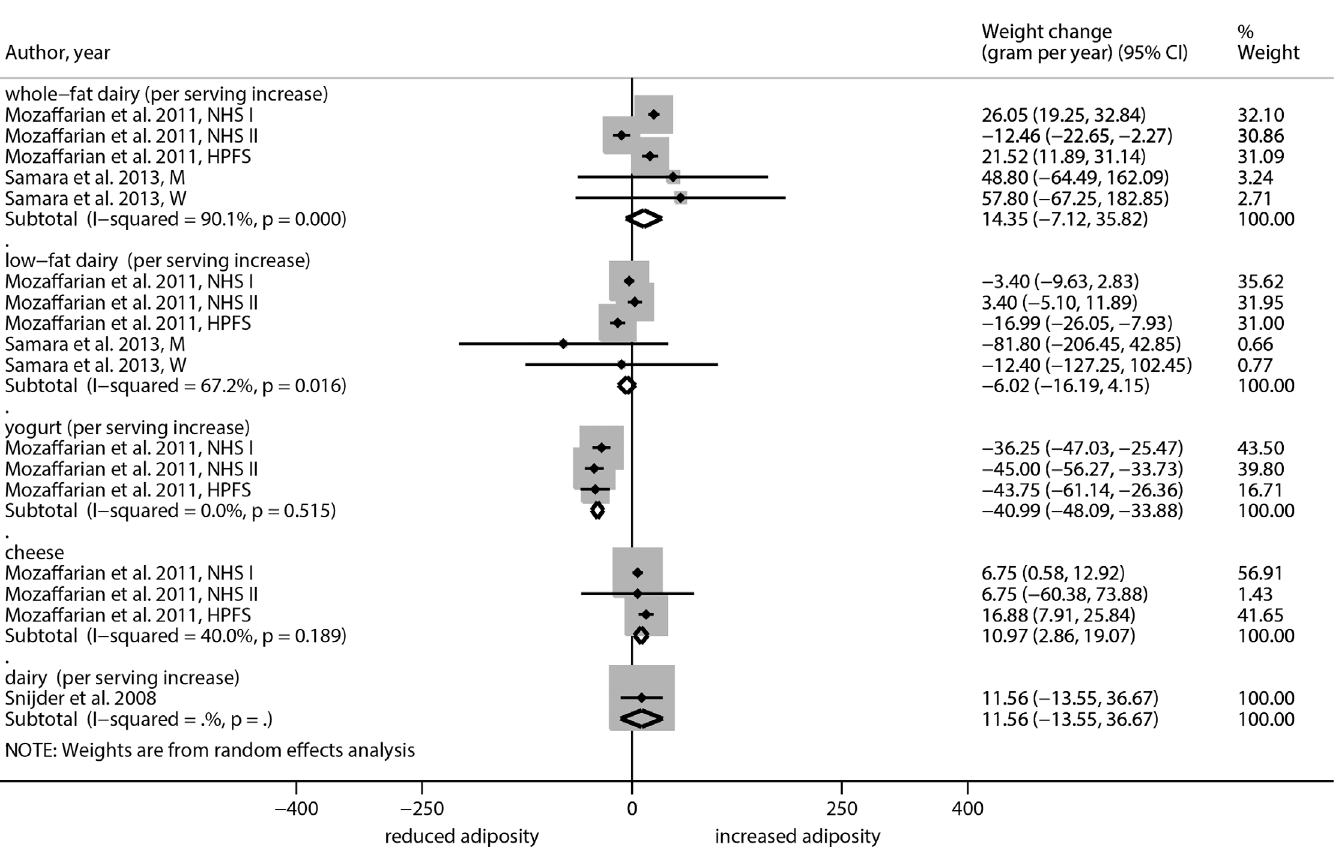
Fig 1. Forest plot of associations between changes in body weight (gram/year) and dairy consumption in cohort studies of adults.